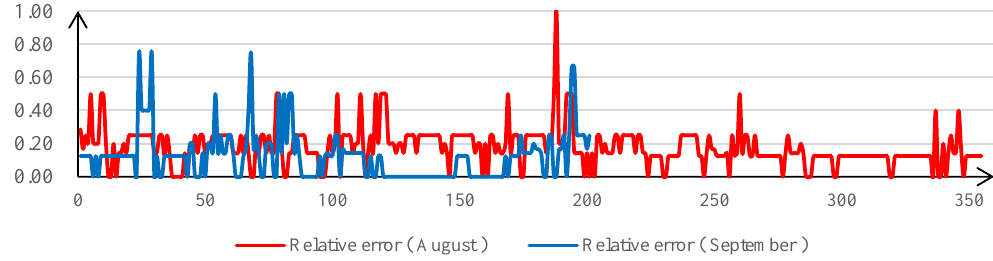
Figure 7. The relative error of referred visibility compared to the data from Chinese ninth Arctic science expedition.